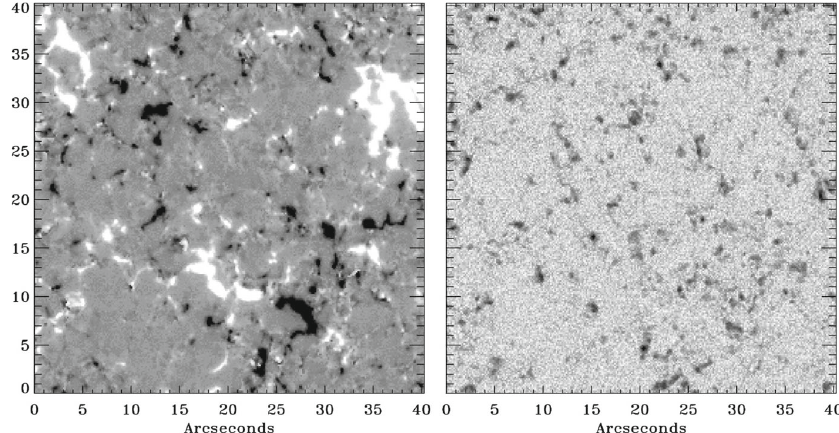
Fig. 10 Longitudinal (left) and transverse (right) magnetogram signals in a 40 (cid:2)(cid:2) × 40 (cid:2)(cid:2) IN area observed by the Hinode SP at a resolution of 0 . 3 (cid:2)(cid:2) . The full maps are shown in Fig. 1. White and black in the longitudinal flux density map represent positive and negative polarity fields, respectively. Black in the transversemagnetogramindicatelargelinearpolarizationsignals.Theleftpanelsaturatesat ± 50Mx cm − 2 , the right panel at 200 Mx cm − 2 . Image reproduced with permission from Lites et al. (2008), copyright by